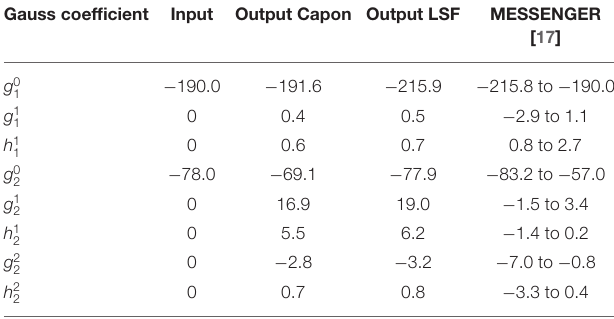
TABLE 1 | Capon’s and LSF estimators for the internal Gauss coefficients in